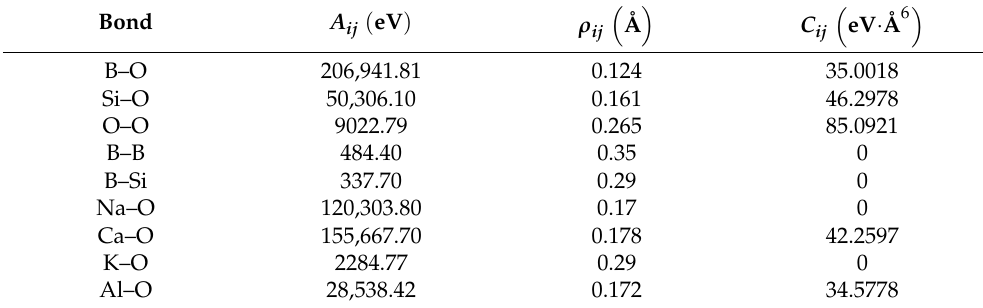
Table 6. Potential function parameters used in this study [27,28].